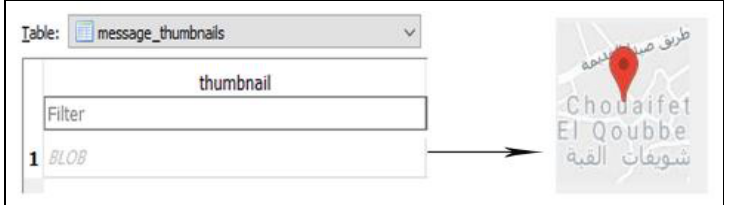
Figure 17. Geolocation latitude and longitude